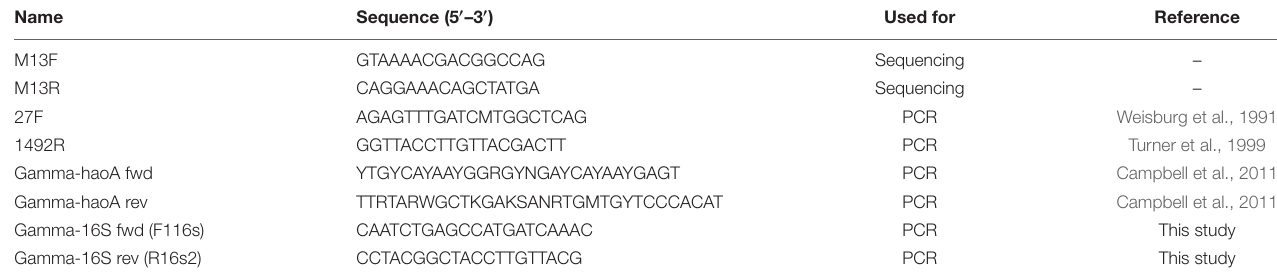
TABLE 3 | Primers used in this